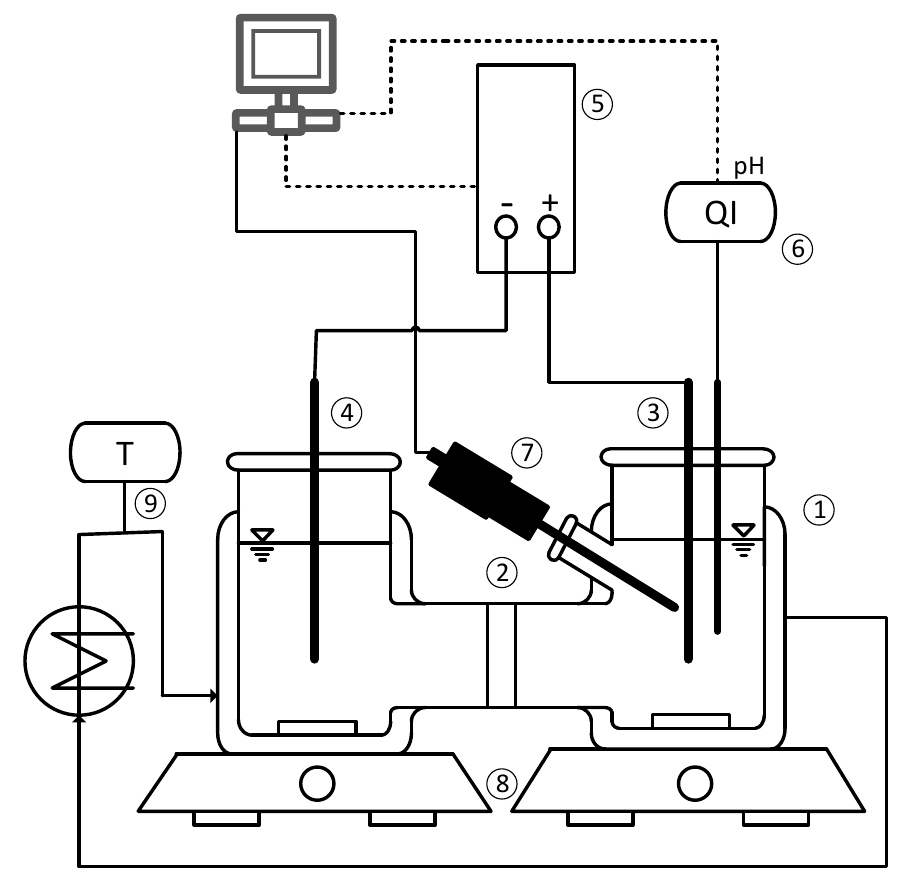
Figure 3. Experimental setup for the determination of the MSZW: (1) H-cell, (2) cation-exchange membrane, (3) anode, (4) cathode, (5) power source, (6) pH probe, (7) endoscope, (8) magnetic stirrers and (9)